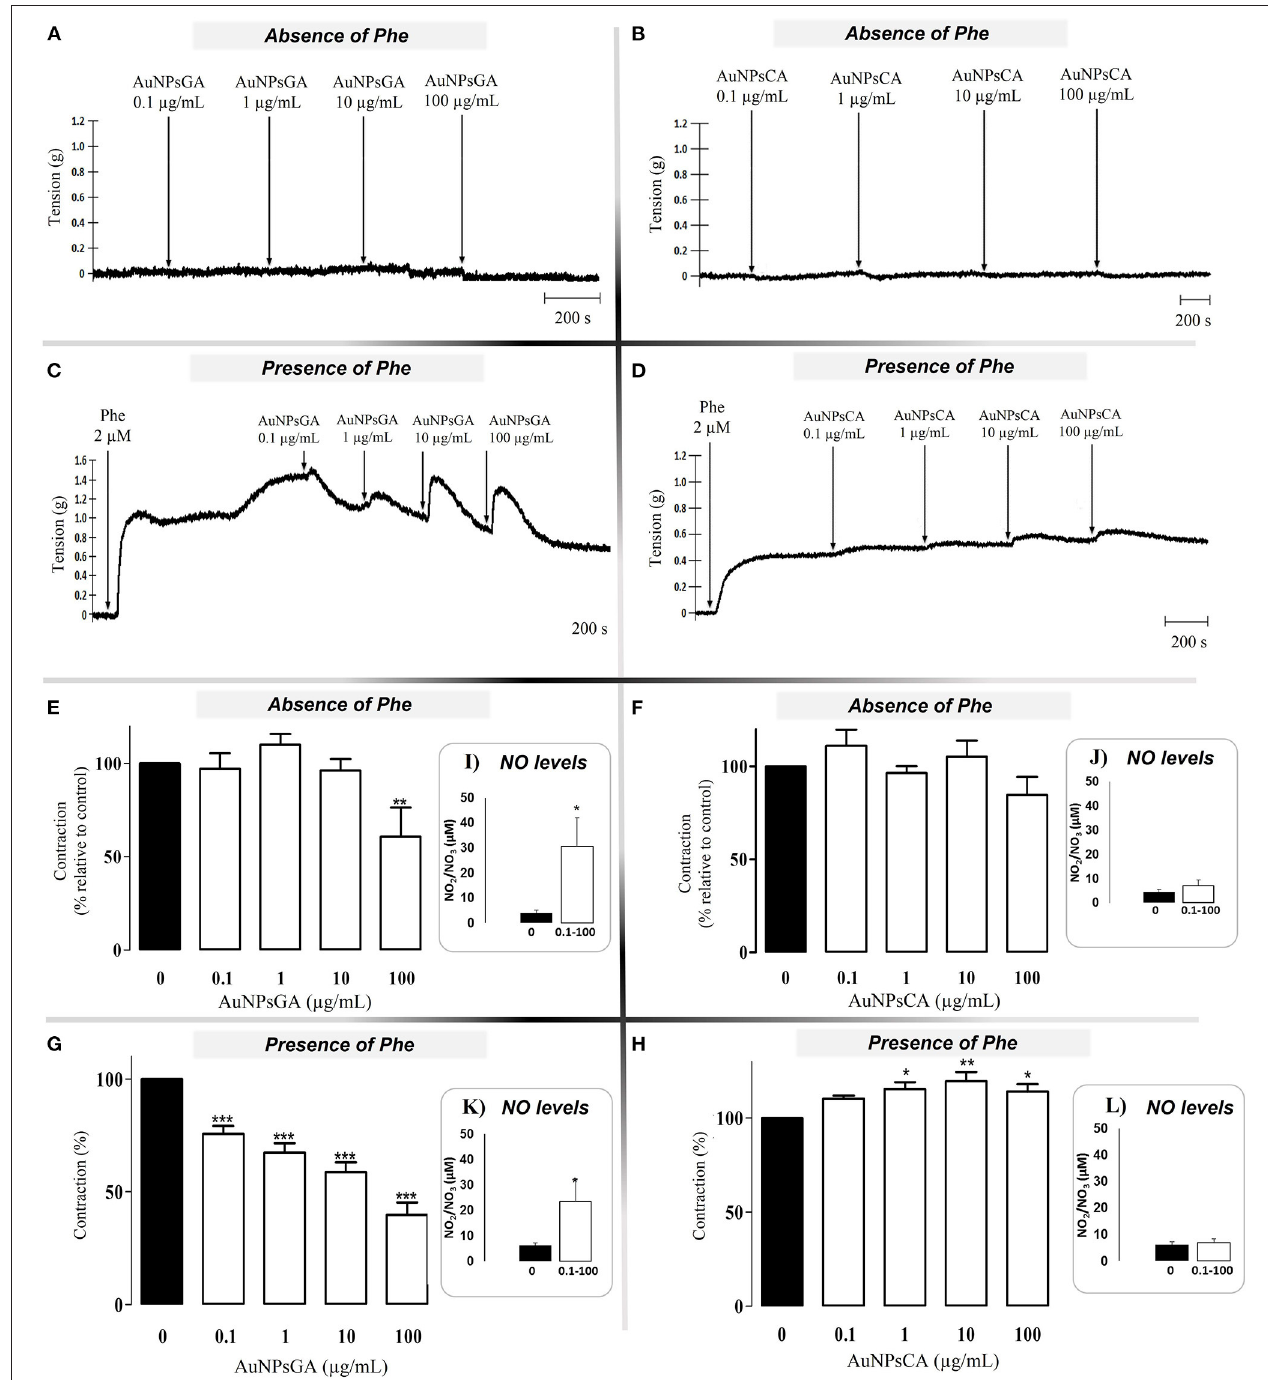
FIGURE 2 | Effects induced by increasing concentrations of AuNPsGA and AuNPsCA. Cumulative concentrations ( µ g/mL) of AuNPs of AuNPsGA (A) and AuNPsCA (B) did not induce an effect on vascular tone in the aortic rings in absence of Phe 2 µ M. Cumulative doses of AuNPsGA (C) and AuNPsCA (D) induced a vasodilator and vasocontraction effect on precontracted aortic rings with Phe 2 µ M, respectively. Results are representative of three independent experiments. Percentage of contraction induced by AuNPsGA and AuNPsCA (0.1, 1, 10, and 100 µ g/mL) in the absence (E,F) and presence (G,H) of Phe 2 µ M, calculated as the percentage of tension based on 100% contraction induced by Phe 2 µ M. NO production, in the absence and presence of AuNPsGA and AuNPsCA (0.1, 1, 10 and 100 µ g/mL), also in the absence (I,J) and presence (K,L) of Phe 2 µ M was determined by Griess method. Values are represented as mean ± SEM ( n = 3). * P < 0.05, ** P < 0.01 and *** P < 0.001 vs. control (0 µ